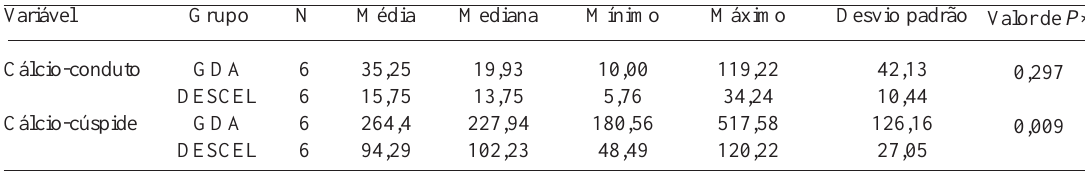
Tabela 2. Mensuração de cálcio nas cúspides valvares e condutos.